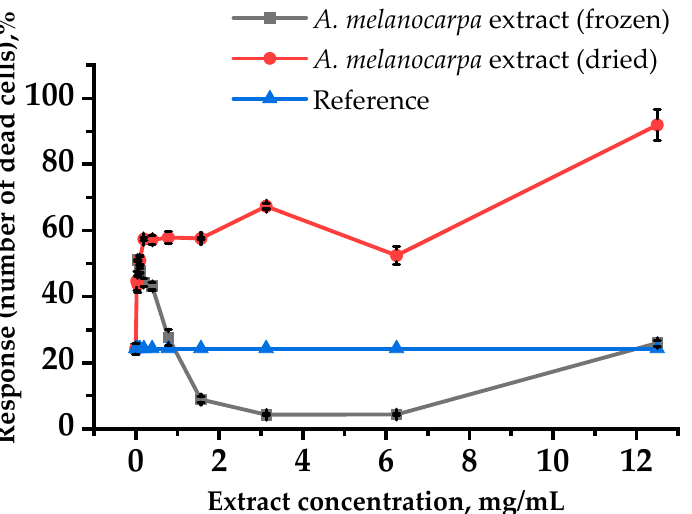
Figure 3. A. melanocarpa fruit extracts’ cytoprotective activity against the RPMI-1788 human lym- phoblast cell line.